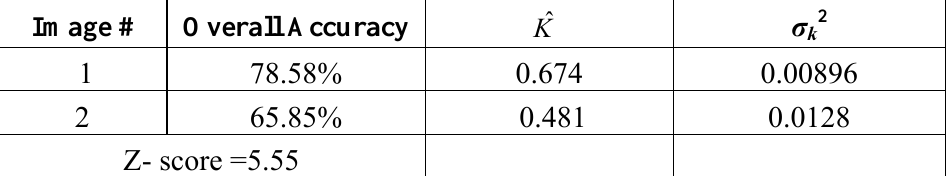
Table 3C. Accuracy assessments for the classification results in Tables 3A and 3B.